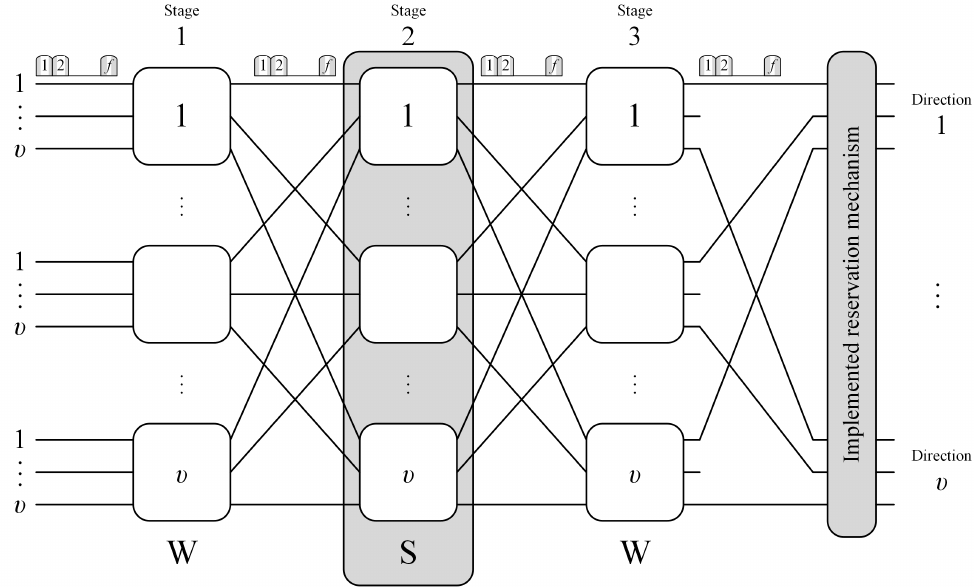
Figure 2. Structure of a switching network with implemented reservation mechanism.